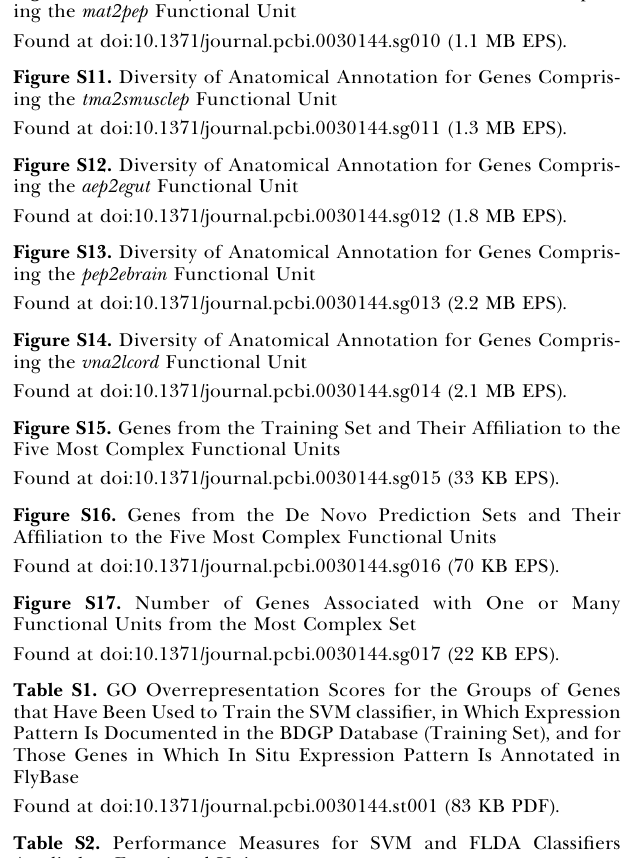
Figure S1. Average Microarray Gene Expression Profiles with Respect to Sets of Anatomical Structures Selected to Form Functional Units Figure S2. Supervised Classification of Microarray Gene Expression Data Figure S3. Histograms of Distance from Separating Hyperplane for Genes for Which De Novo Predictions Are Made Figure S4. Estimation of Prediction Accuracy for Three Functional Units Constructed with Genes Involved in Early Development of